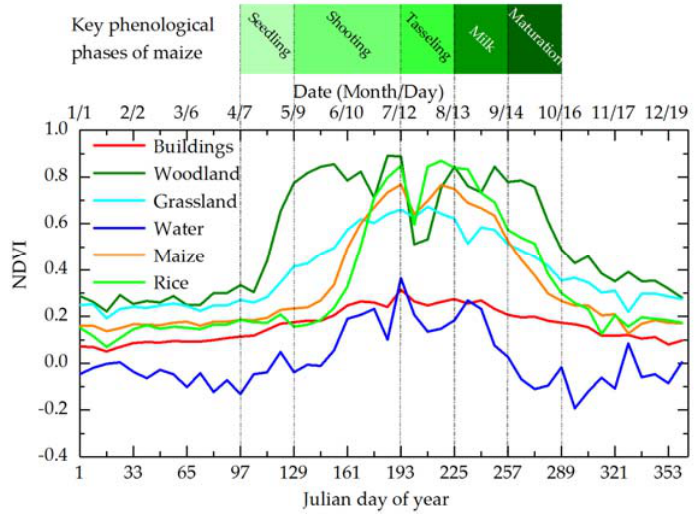
Figure 4. Averaged normalized difference vegetation index (NDVI) time-series curves for different land cover types based on training samples during 2015.